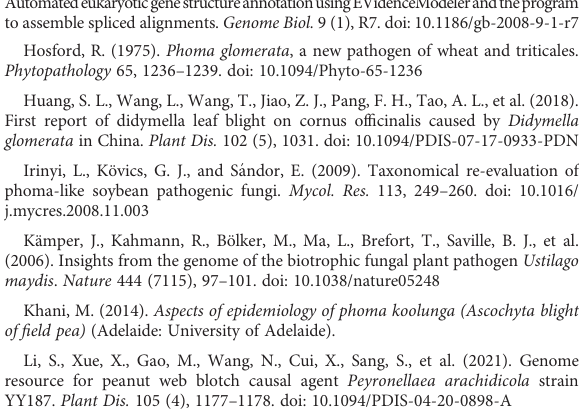
SUPPLEMENTARY FIGURE 1 Genome collinearity of D. glomerata Pj-2 with Didymella keratinophila 9M1, Didymella heteroderae, Didymella pinnodes WTN-11-157, Didymella exigua CBS 183.55 and the Didymella (Ascochyta) rabiei ArMe14. SUPPLEMENTARY FIGURE 2 Reactions of the Didymella glomerata strain Pj-2 on 30 maize lines representing cultivars, inbred lines and landraces fi ve days post- inoculation. Lesion areas were measured using ImageJ